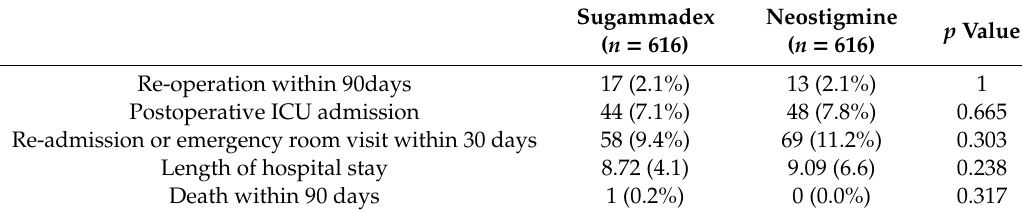
Table 4. Secondary outcomes in the propensity-matched